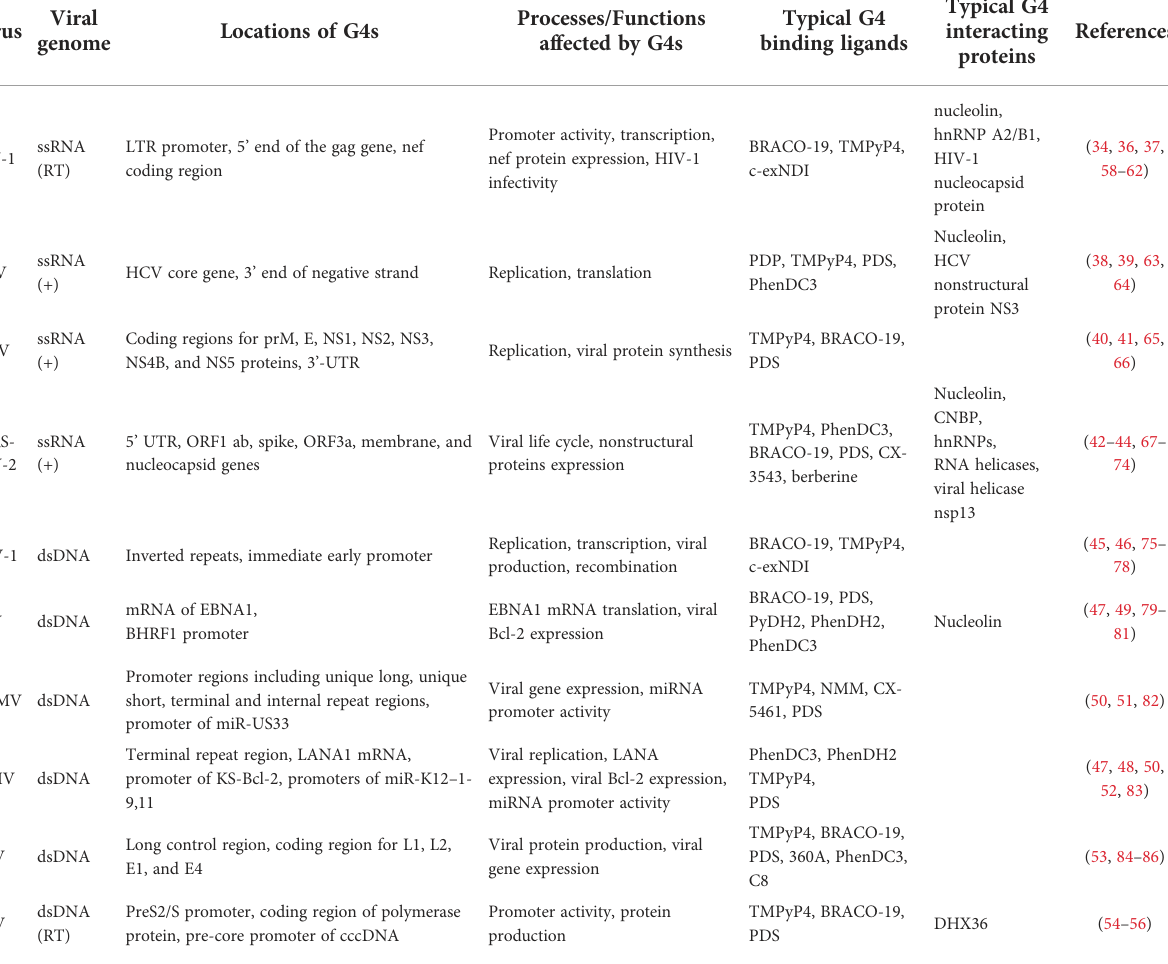
TABLE 2 Overview of locations, functions of G4s in different viruses, and typical G4 binding ligands and proteins used in related